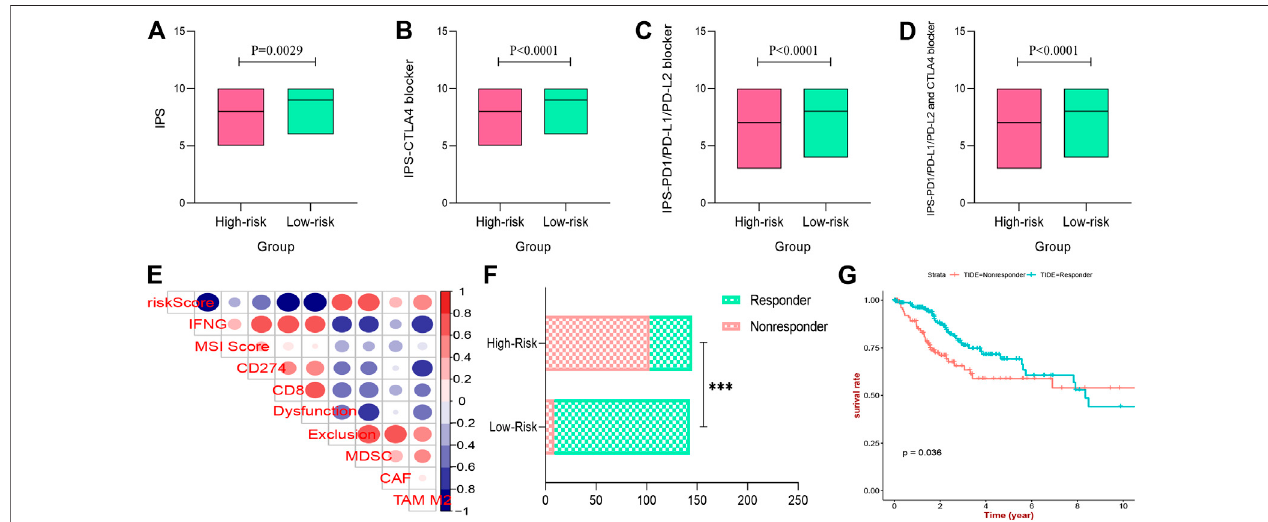
FIGURE 12 | Immunogenicity and immunotherapeutic sensitivity with prognostic signature. (A – D) the IPS, IPS-CTLA4 blocker, IPS-PD1-PD-L1-PD-L2 blocker, and IPS-PD1-PD-L1-PD-L2-CTLA4 blocker scores between low- and high-risk groups. (E) Immune in fi ltrating cell pro fi le of tumor microenvironment of CESC patients. (F) The differences of immunotherapy sensitivity between low- and high-risk groups. (G) Survival analysis of different immunotherapy sensitivity. IPS, Immunophenoscore; ICIs, immune check inhibitors; CESC, cervical squamous cell